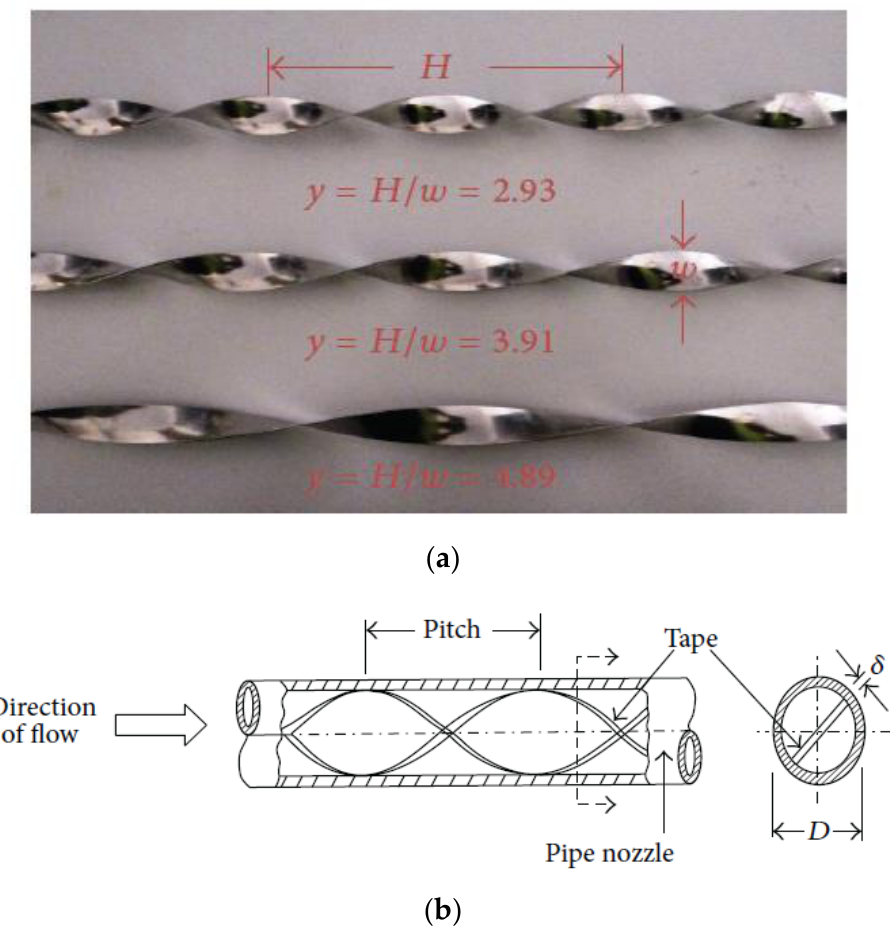
Figure 6. Twisted tape ( a ) at various twist ratios and ( b ) geometry drawing of twisted tape inserted into a jet impinging nozzle. “Reprinted with permission from Ref [69]. Copyright 2014, SAGE Journal ”.